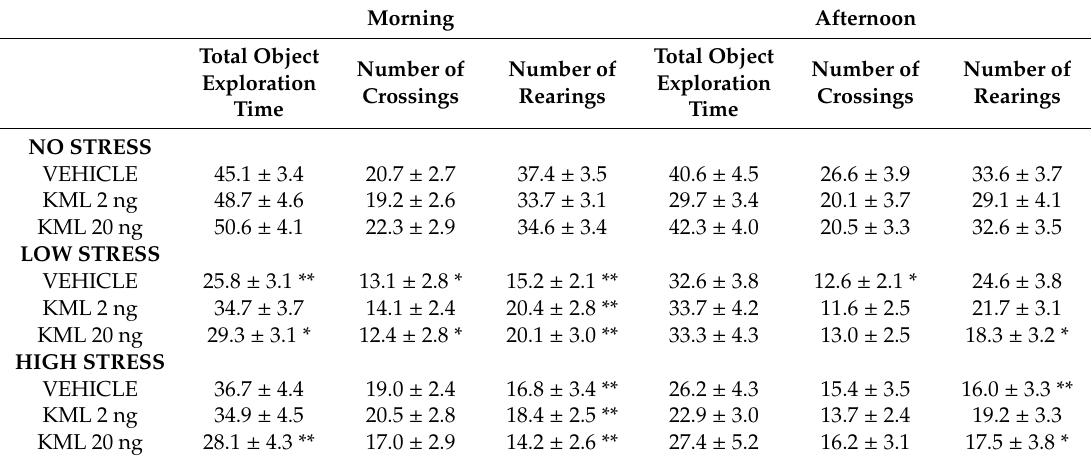
Total time spent exploring the two objects (in seconds, s) and the number of crossings and rearings of all groups tested in the morning and in the afternoon. * p < 0.05; ** p < 0.01 vs the corresponding no stress group. Data are expressed as mean ± SEM ( n = 10–12 per